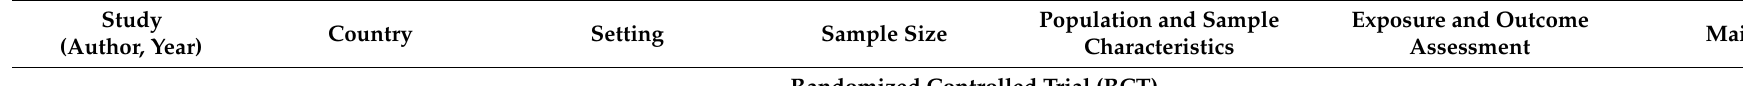
Table 2. Characteristics of included